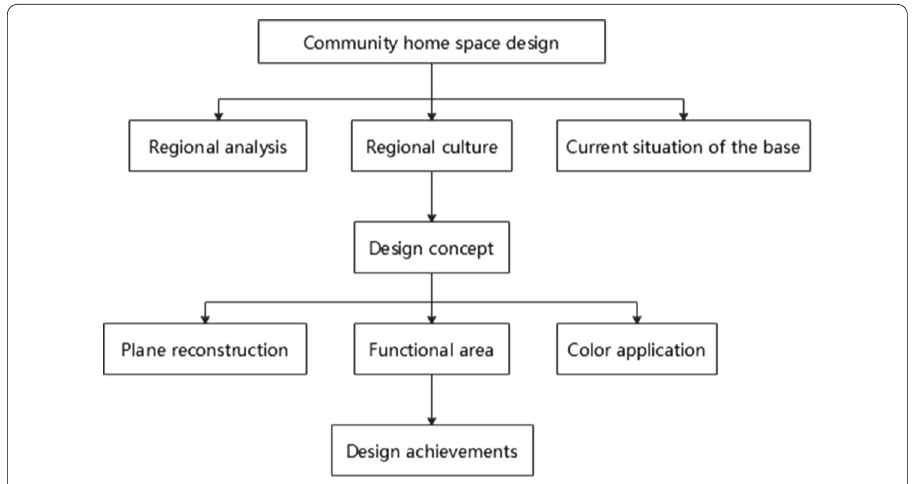
Fig. 2 Flowchart of community space